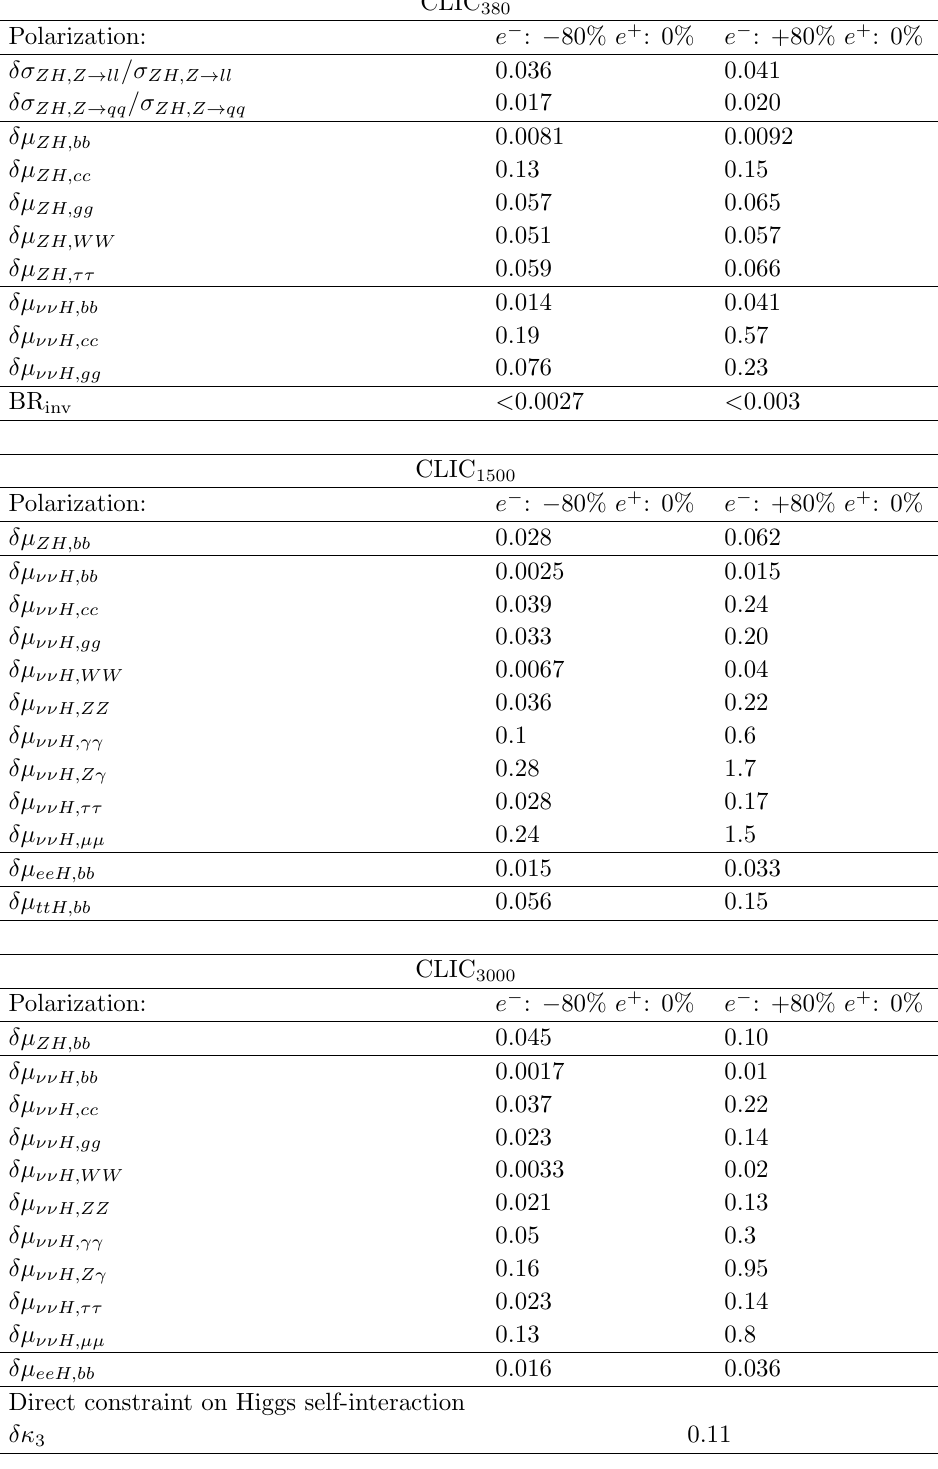
Table 23 . Inputs used for CLIC projections at the three energy stages and two polarisations. All uncertainties are given as fractional 68% CL intervals and are taken to be symmetric. The upper limits are given at 68%